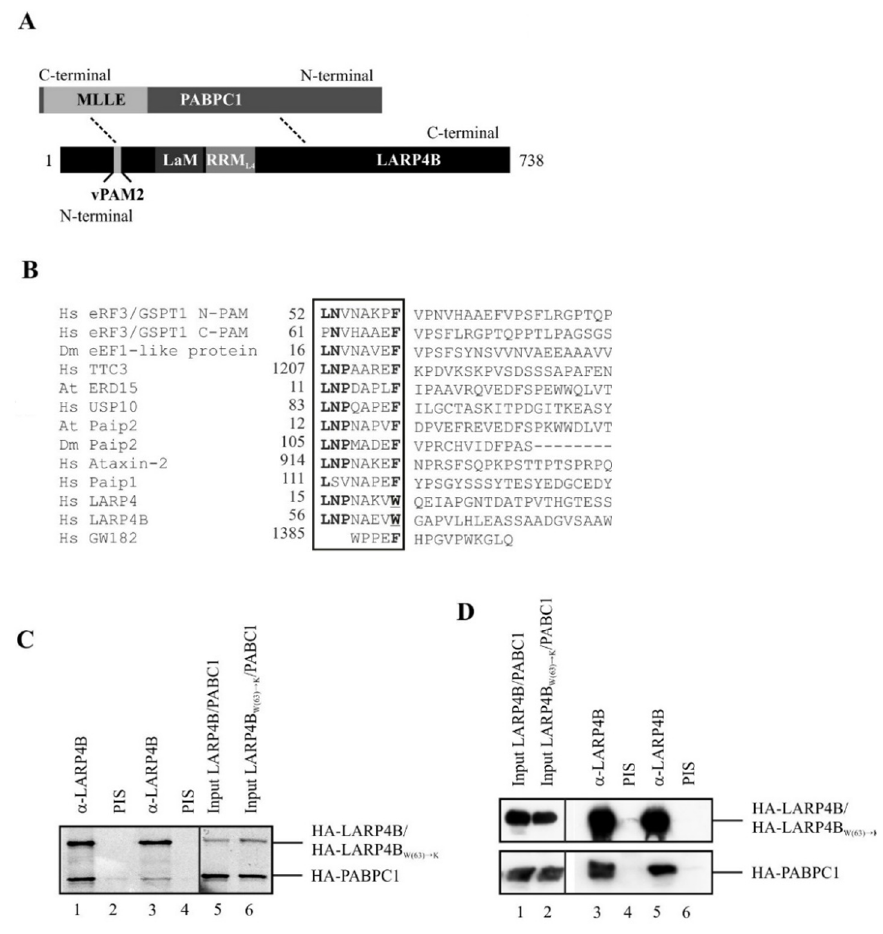
Figure1. CharacterisationofthePAM2wmotifanditsbindingtopoly(A)bindingproteinC1cytoplasmic 1 Mademoiselle domain (PABPC1-MLLE). ( A ) A schematic model of the LARP4B–PABPC1 interaction. ( B ) Sequence alignment of PAM2 motifs of several proteins from di ff erent organisms (Hs—Homo sapiens; Dm—Drosophila melanogaster; At—Arabidopsis thaliana): Hs eRF3 (elongation release factor 3), Hs TTC3 (E3 ubiquitin-ligase TTC3), Hs Ataxin-2, Paip1 [Poly(A) interacting protein 1], Hs LARP4 and LARP4B (La-related proteins 4 and 4B), Dm eEF1-like protein (eukaryotic elongation factor 1-like protein), Dm Paip2 [Poly(A) interacting protein 2], At. ERD15 (early response to dehydration 15), At. Paip2 [Poly(A) interacting protein 2]. Conserved amino acids are highlighted by bold characters, the variant tryptophan residues of LARP4 and LARP4B are underlined. ( C ) In vitro binding experiment using protein-G-Sepharose coupled antibody against LARP4B (lanes 1 and 3) or a pre-immune serum (lanes 2 and 4). HA-PABPC1, as well as HA-LARP4B or HA-LARP4B (W63) → K , respectively, were co-translated in vitro, [ 35 S]-labeled and immunoprecipitated with the indicated antibodies. Bound proteins were detected by autoradiography (HA-LARP4B lanes 1-2, HA-LARP4B (W63) → K lanes 3–4). Input, 5% of [ 35 S]-labeled HA-PABPC1, HA-LARP4B (lane 5) or HA-LARP4B (W63) → K (lane 6). ( D ) Immunoprecipitation of HEK293 cell extracts overexpressing either HA-LARP4B or HA-LARP4B W(63) → K using an antibody against LARP4B (lanes 3 and 5) or a pre-immune serum (lanes 2 and 4). Lanes 1 and 2 show the transfection controls. The gel was analyzed by Western